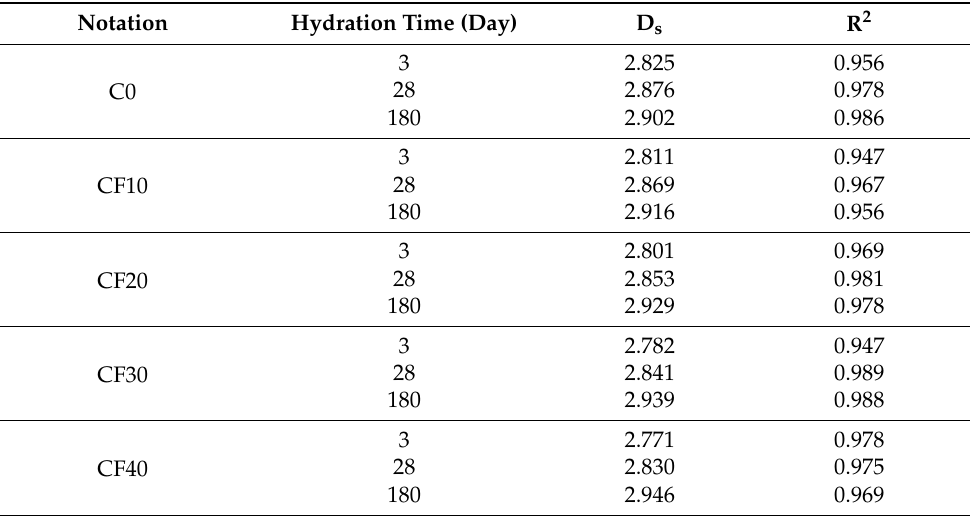
Table 5. D s values of face slab concrete added with different fly ash